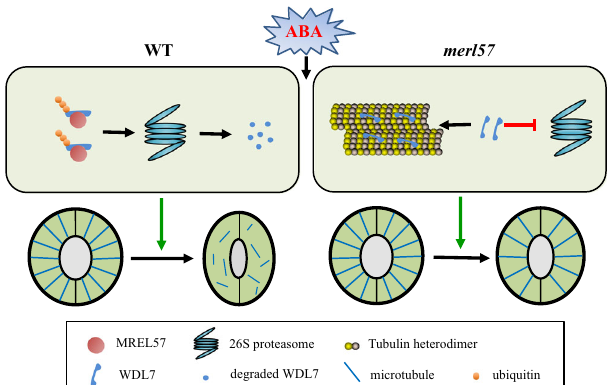
Fig. 8 A hypothetical model for MREL57-WDL7 module function in stomatal closure in response to ABA. Working model for the role of WDL7 proteolysis in ABA-induced stomatal closure and microtubule disassembly in WT and mrel57 mutant guard cells. WDL7 is a microtubule-stabilizing protein. In WT, the E3 ligase MREL57 ubiquitinates and degrades WDL7 in response to ABA, which facilitates microtubule disassembly and stomatal closure. In mrel57 mutant, the degradation of WDL7 is blocked. WDL7 binds to and stabilizes microtubules, resulting in stomatal closure insensitivity to ABA in mrel57 mutant.